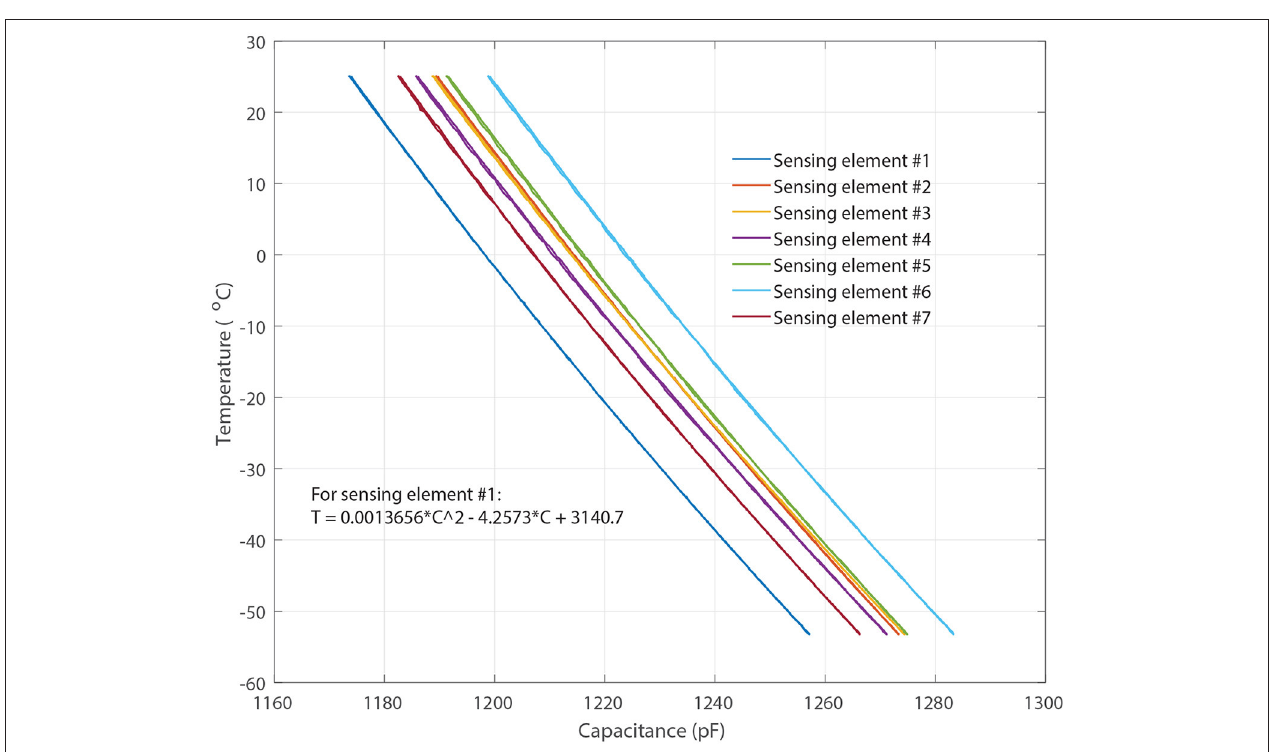
FIGURE 2 | Measured capacitance vs. temperature for each of the sensing elements where Sensing elements #1–7 represent the capacitive sensing elements shown in Figure 4A .